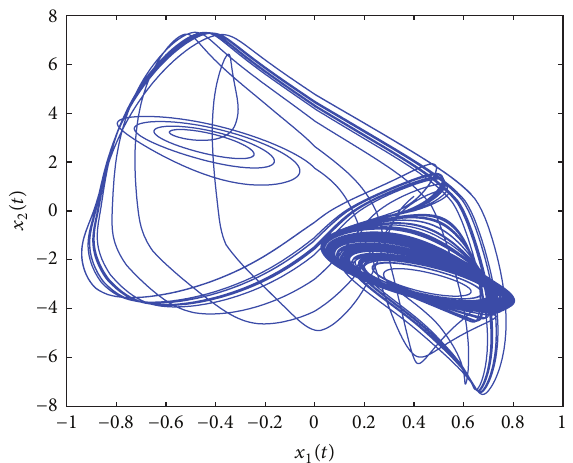
Figure 1: Trajectory of system (1) with initial value 𝑥(𝑡) = (0.4, −0.6) 𝑇 , 𝑡 ∈ [−1,0] .